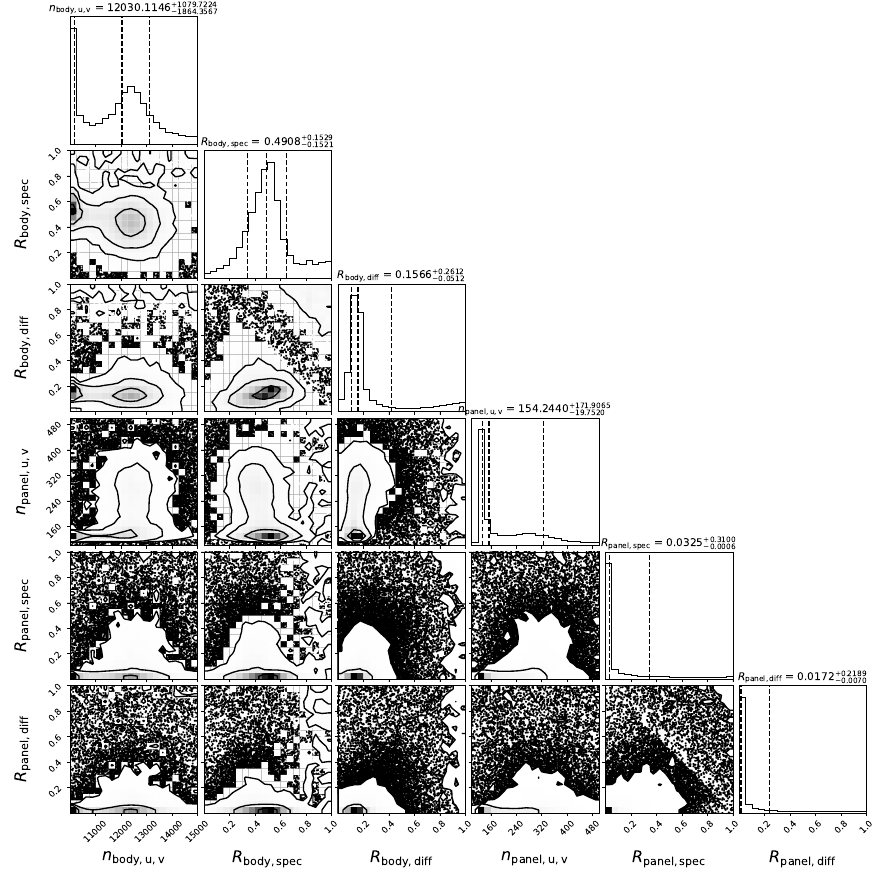
Figure 11. The parameter distributions of Object